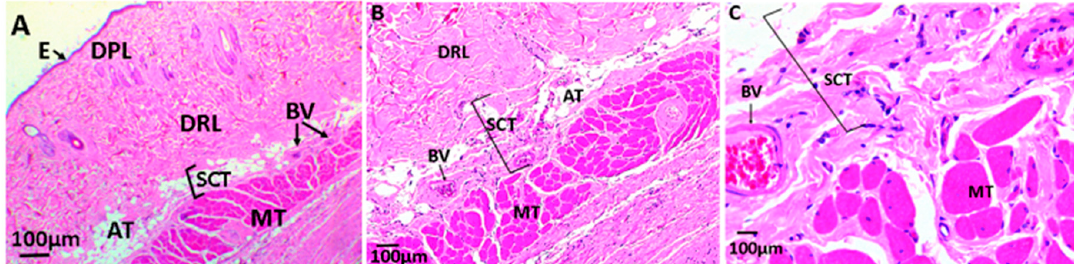
Figure 11. ( A – C ) Histological analysis of sample control. E: Epidermis; DPL: Dermis papillary layer;